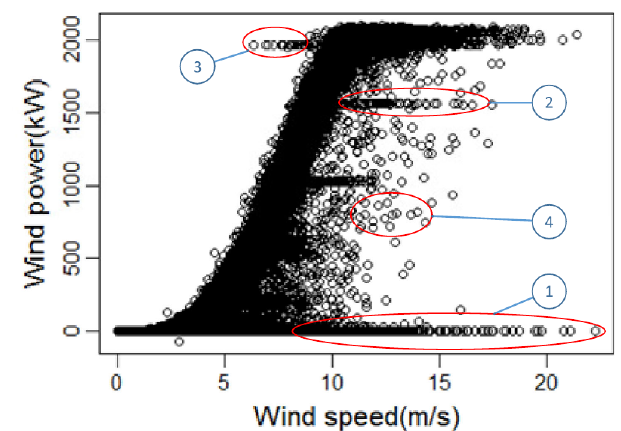
Figure 2. Abnormal data in wind power curves (extracted from [38]).